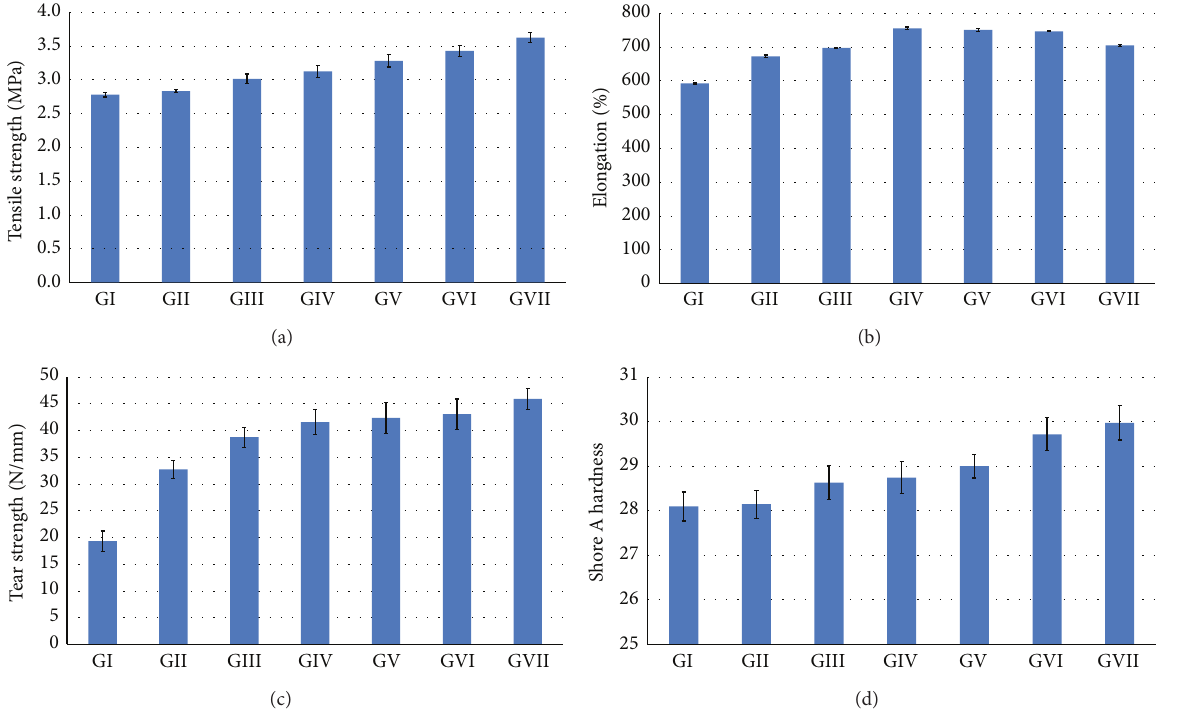
Figure 2: Comparative mechanical properties of the material investigated. (a) Tensile strength; (b) percentage elongation; (c) tear strength; (d) shore A